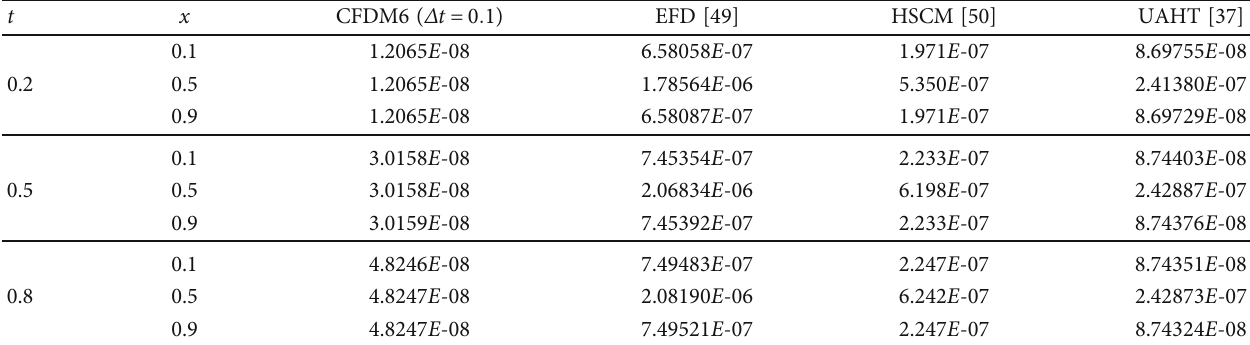
Table 9: Comparison of absolute error of Example 6 with β = 5 , γ = 10 , η = 0 : 0001 , δ = 2 , h = 0 : 1 , and Δ t = 0 : 0001 .